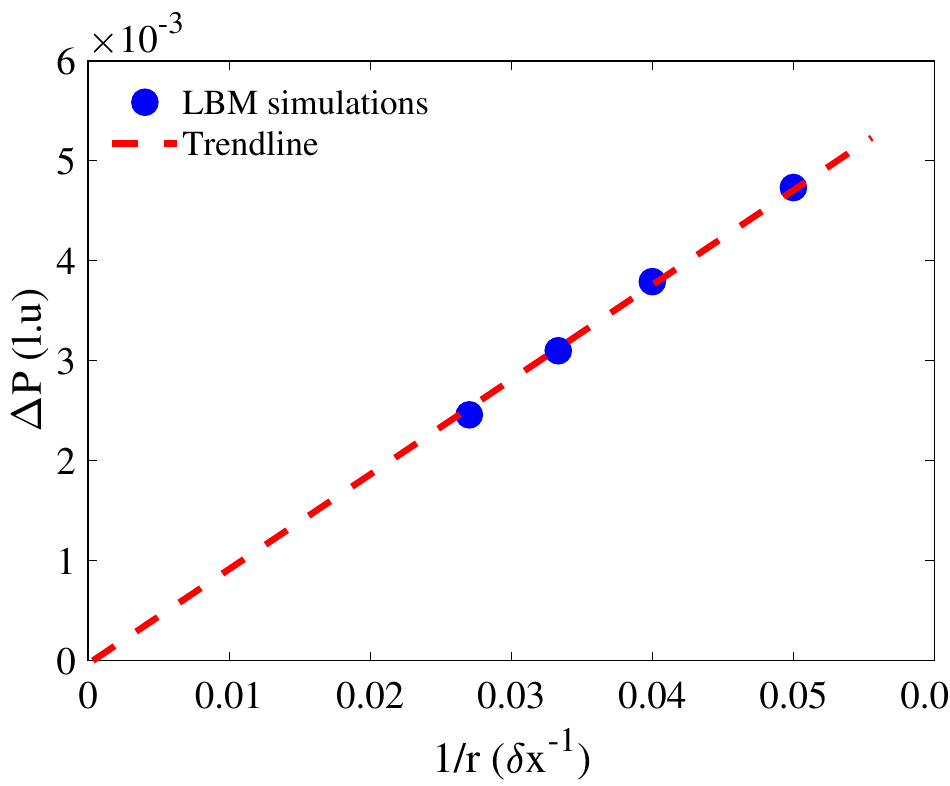
Figure 3. Linear relation between the pressure difference and the inverse of radius for estimating the surface tension (l.u represents the lattice